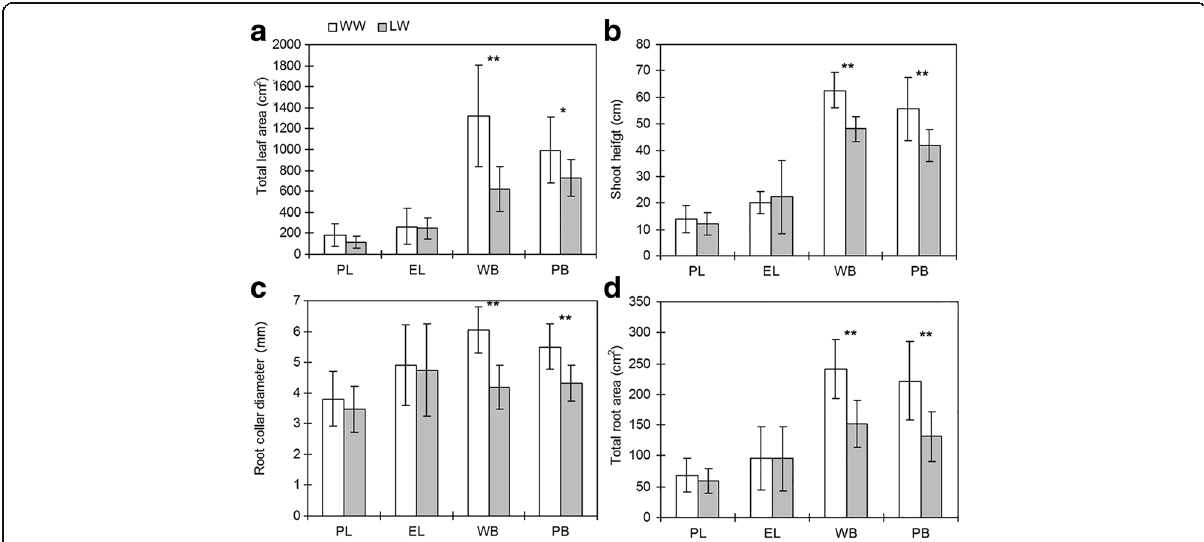
Fig. 4 Morphological indexes of four species treated by two water treatments. a : Total leaf area (cm 2 ), b : Shoot height (cm), c : Root collar diameter (mm), d : Total root area (cm 2 ). PL: Prince Rupprecht ’ s larch, EL: eastern larch, WB: white birch, PB: paper birch, WW: well-watered seedlings shown by open bars , LW: low-watered seedlings shown by shaded bars. Asterisks above bars indicate significant difference between the two treatments, * difference at P <0.05, ** difference at P <0.01